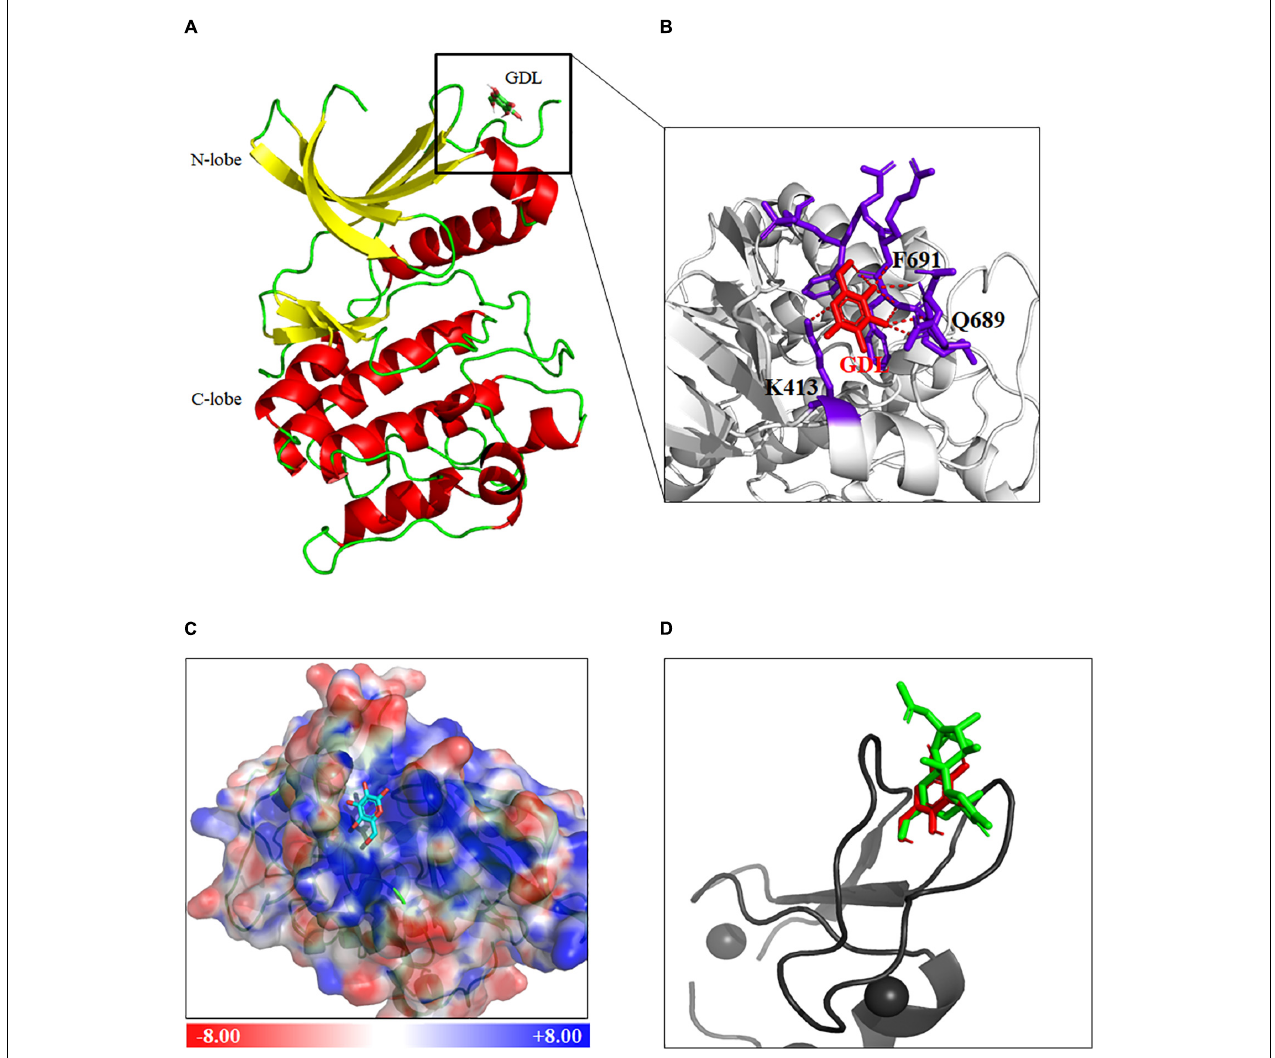
FIGURE 6 | Protein kinase C is a putative target of GDL by bioinformatics analysis and molecular docking studies. (A) Docking of GDL into PKC (PDB code 1XJD) by AutoDock Vina, and the protein-ligand interaction of PKC and GDL was visualized by PyMOL (www.pymol.org). (B) Formation of hydrogen bonds between GDL and PKC (Red, GDL). (C) Electrostatic surface of PKC structure generated by APBS tool (Blue, positive charge; red, negative charge; Cyan, GDL). (D) Docking of GDL into PKC (PDB code 1PTR) by AutoDock Vina, and comparison of docking poses in PKC between Phorbol-13-acetate (Green) and GDL